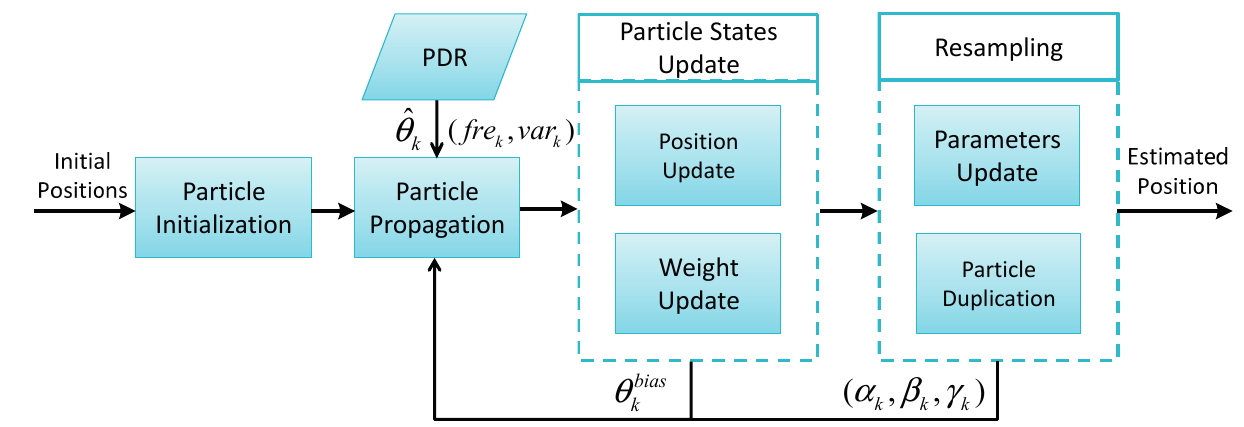
Figure 17. Flowchart of the proposed particle filter algorithm and its correction process.